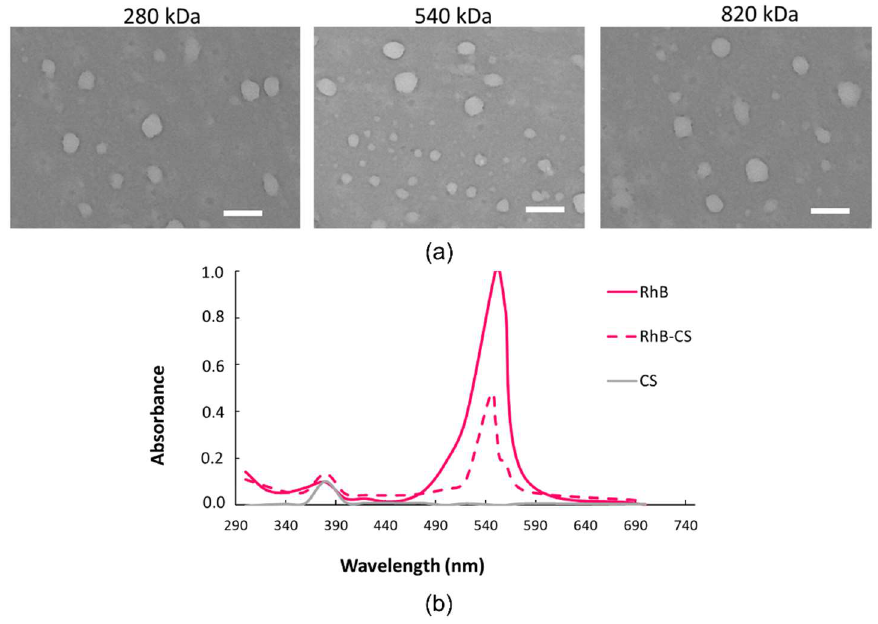
Figure 1. ( a ) TEM images of HA/CS NPs made of 280 kDa, 540 kDa or 820 kDa HA (scale bar = 400 nm); ( b ) UV-vis spectra scanned from 200 nm to 700 nm of CS-RhB conjugate (red dashed line), RhB (red full line) and CS (grey line).